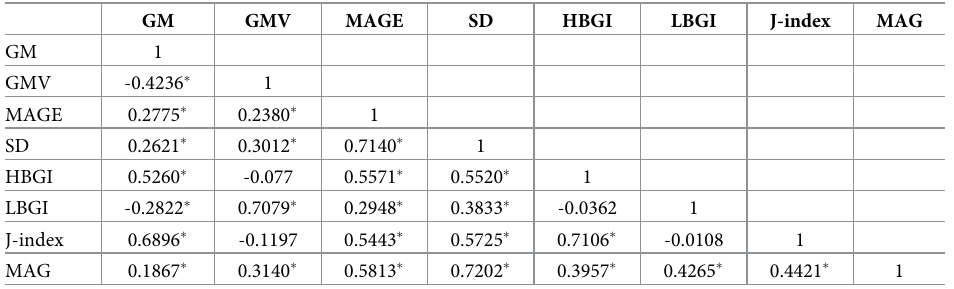
Table 2. Results of correlation analyses among parameters of glycaemic variability.